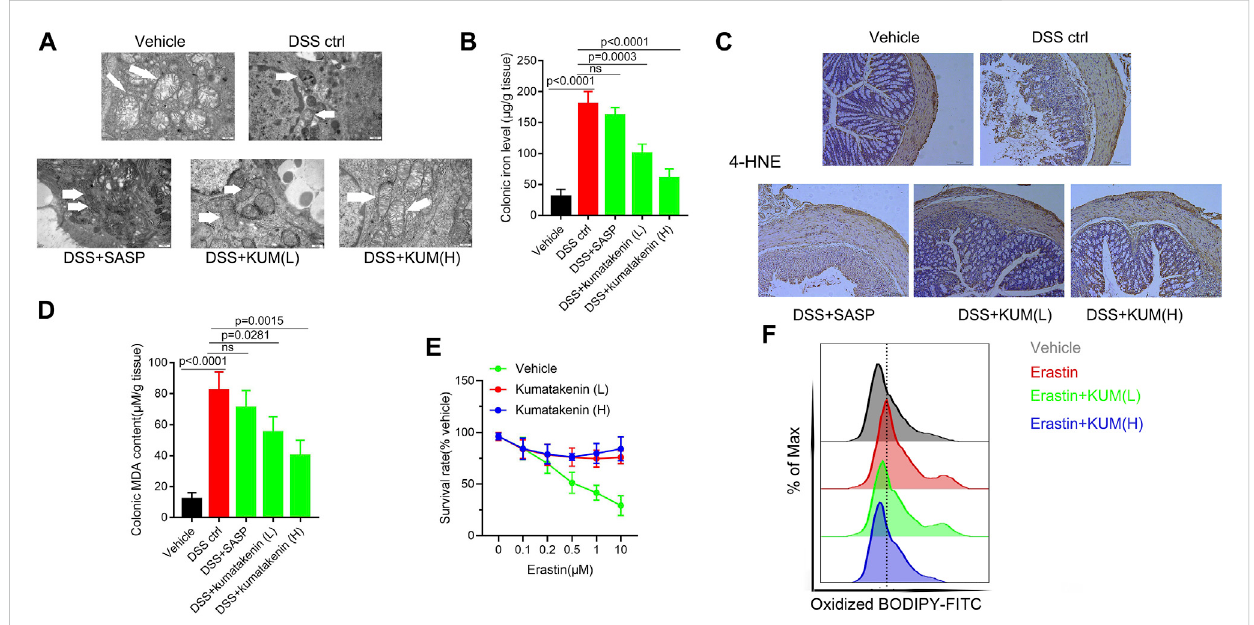
FIGURE 3 Kumatakenin inhibited ferroptosis in colonic epithelial cells from colitis mice. (A) Mitochondrial morphology in colonic epithelial cells from colitis mice was determined using transmission electron microscopy (scale bar = 0.5 μ m). (B) Colonic iron and (C,D) 4-HNE and MDA expression were measured tore fl ect thelipid peroxidation rate(scalebar= 200 μ m). (E) Cell survival rateand (F) lipidROS levels ofMODE-K cells after ferroptosis inducer erastin treatment were also